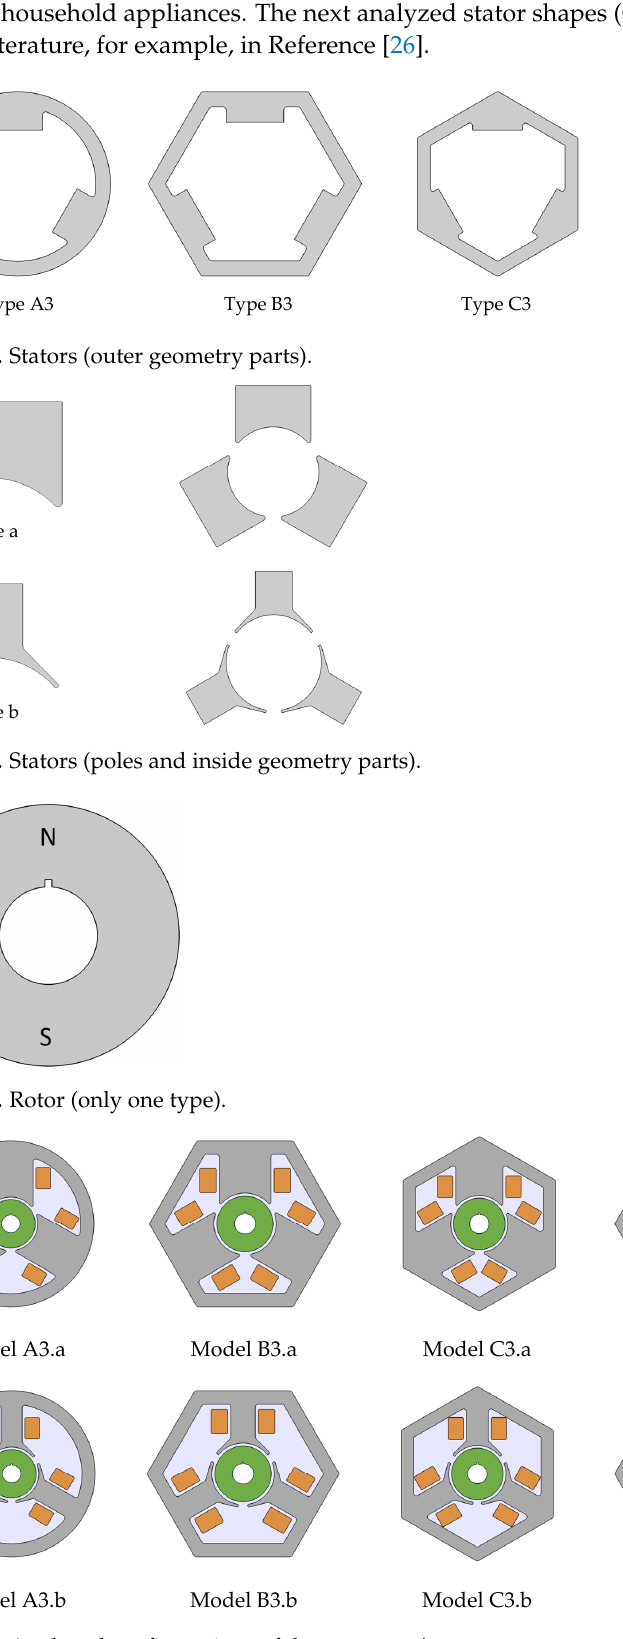
( b ) Figure 9. The idea of COMSOL parts and construction of motors: ( a ) diagrams and ( b ) model B3.b. The basic model is the model marked as B3.b3 (Figure 9), for which dimensions were adopted by following the dimensions of the real motor from Figure 1. For the remaining models, analogous dimensions were adopted. For example, motors with a circular stator have a stator radius corresponding to a wheel into which can be inscribed a hexagon corresponding to the reference motor. The values of physical dimensions (for example, stator outer/inner diameters, air gap length, rotor outer/inner diameters and motor width, and coil width/height) and electric parameters (for example, voltage and power) of the reference motor are reported in Table 1. The comparison of geometric dimensions for two different models is shown in Figure 10. Table 1. Basic parameters of reference device. Parameters